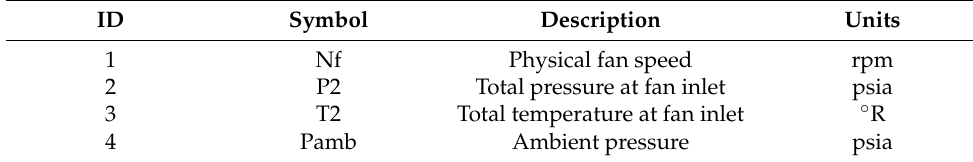
Table 2. Operating conditions U in ProDiMES [20].